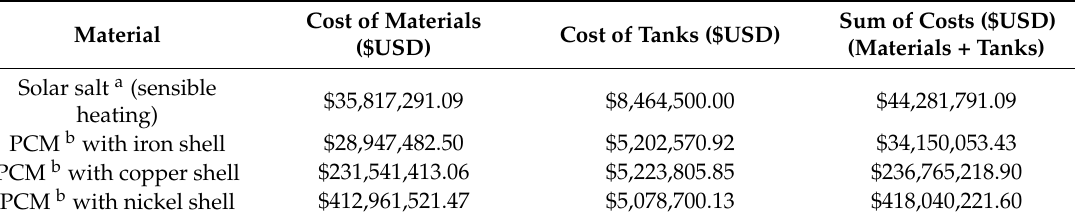
Figure 4. EPCMs thermal energy in function of the time. Table 5. TES cost of a CSP